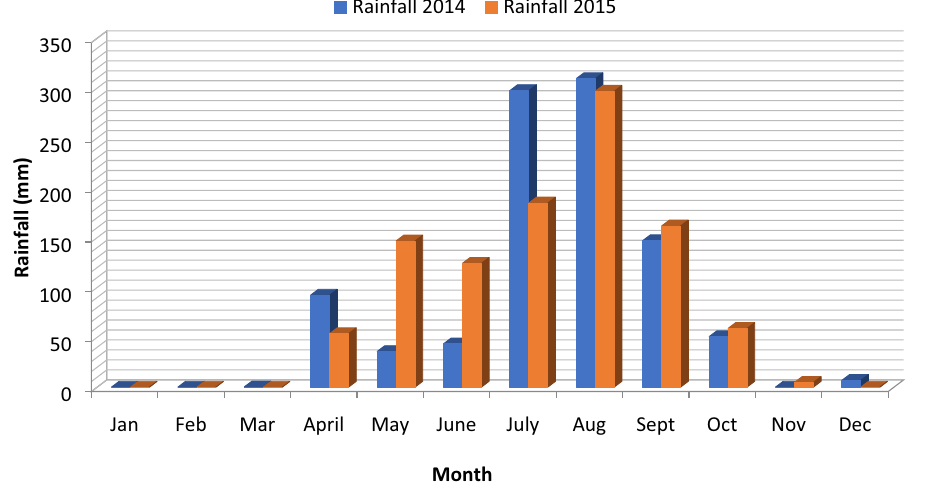
Figure 1. Season rainfall distribution measured during the 2014 and 2015 sweet sorghum growing season at the ITRAD Research Centre in Bébédjia,